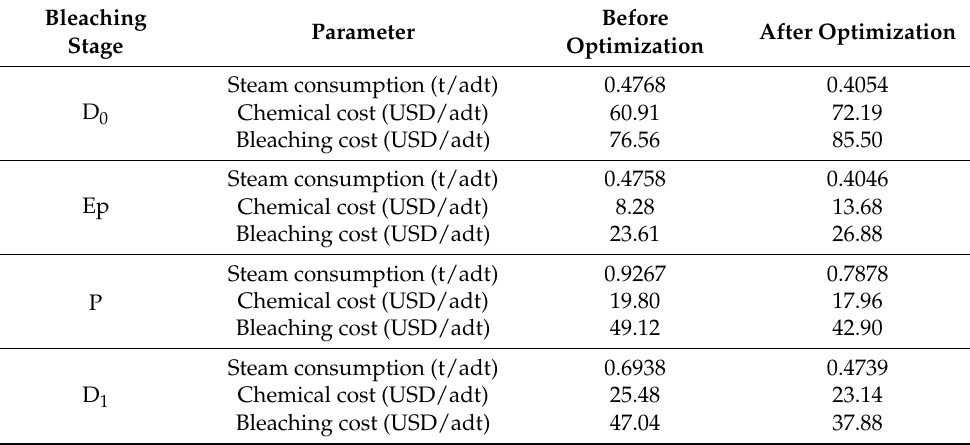
Table 5. Comparison results before and after